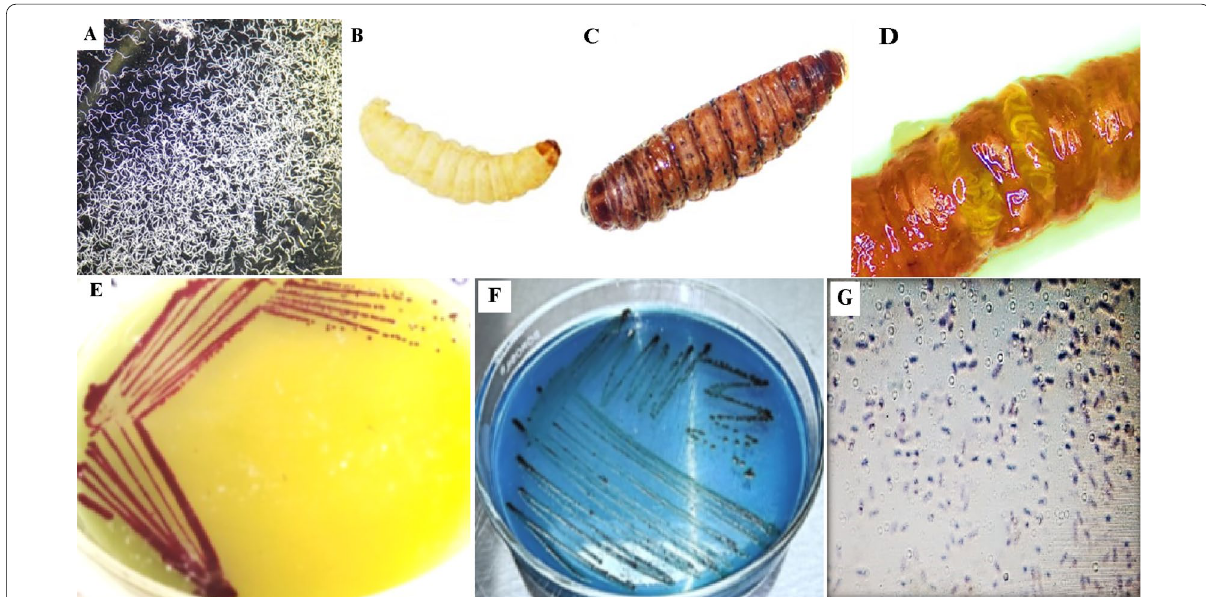
Fig. 1 A Infective juvenile suspension of nematodes collected in the White’s trap. B Healthy Galleria larva. C Entomopathogenic nematode infected cadaver. D Nematodes inside the host body. E Colonies produced by bacteria on NBTA media. F Change in media colour due to pigmentation by